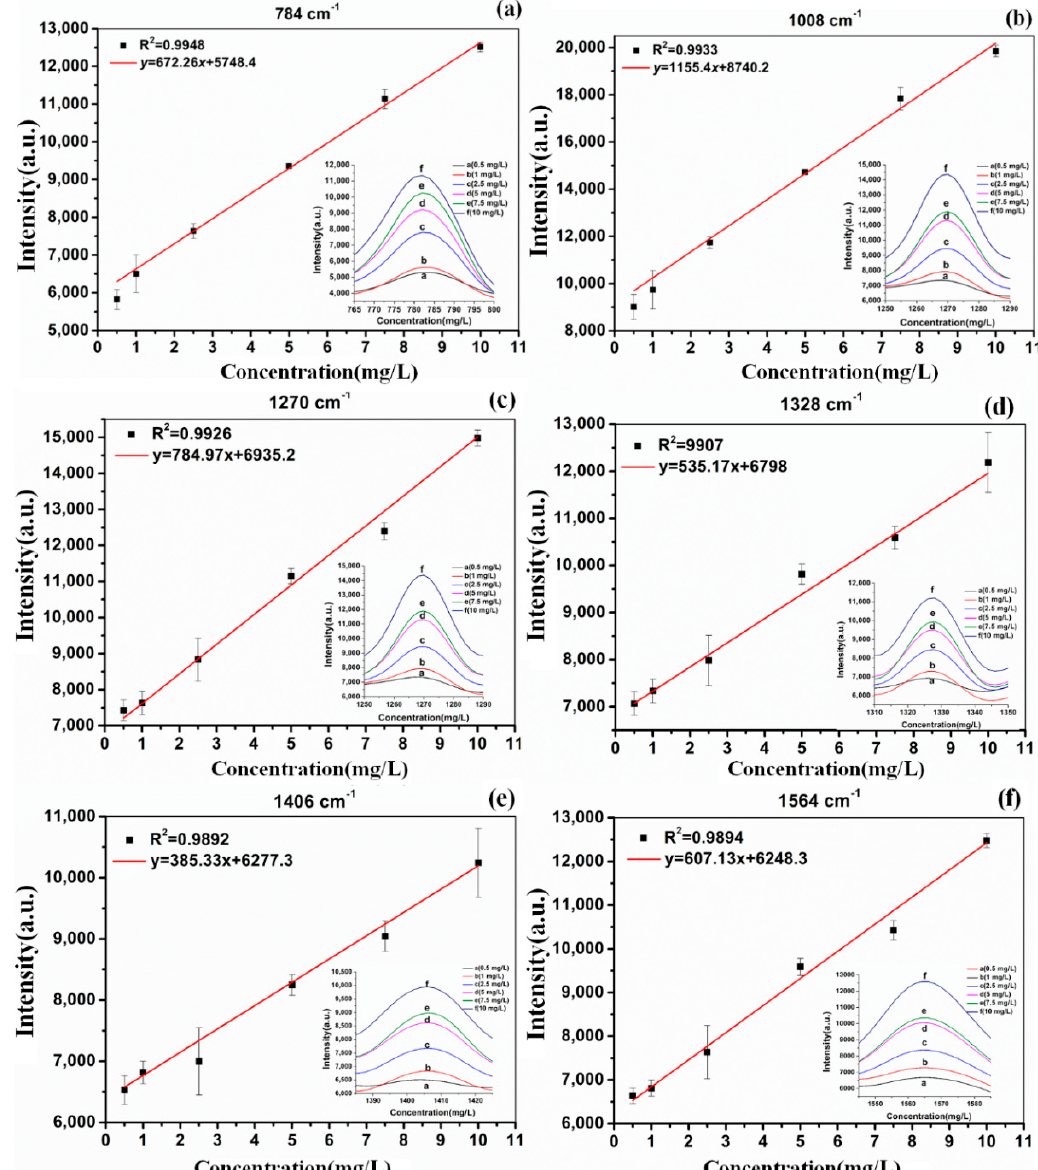
Figure 5. The linear regression equations between Raman peak intensity and soil TBZ concentration at different Raman peaks: ( a ) 784 cm − 1 ; ( b ) 1008 cm − 1 ; ( c ) 1270 cm − 1 ; ( d ) 1328 cm − 1 ; ( e ) 1406 cm − 1 ; ( f ) 1564 cm − 1 .